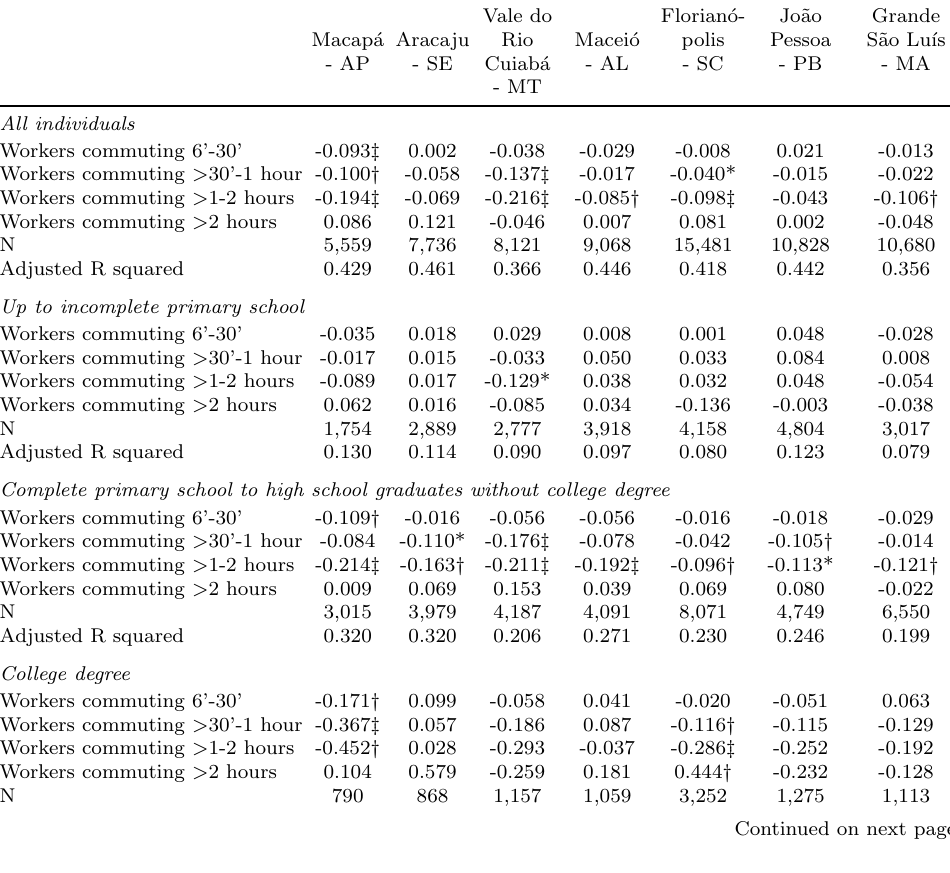
Table 5: OLS regressions of the logarithm of the hourly wage, for all individuals and by education group Vale do Florian´o- Jo˜ao Grande Macap´a Aracaju Rio